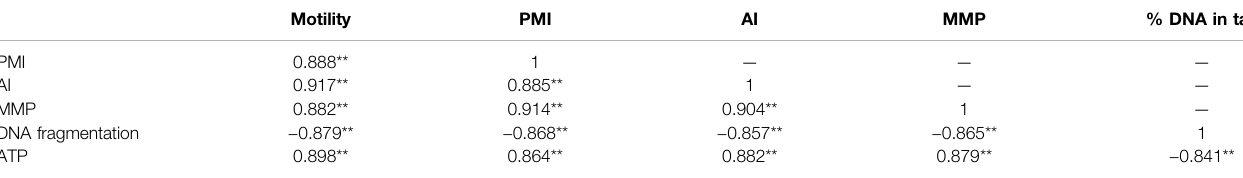
TABLE 2 | Correlation among post-thaw sperm quality parameters of Paci fi c abalone.